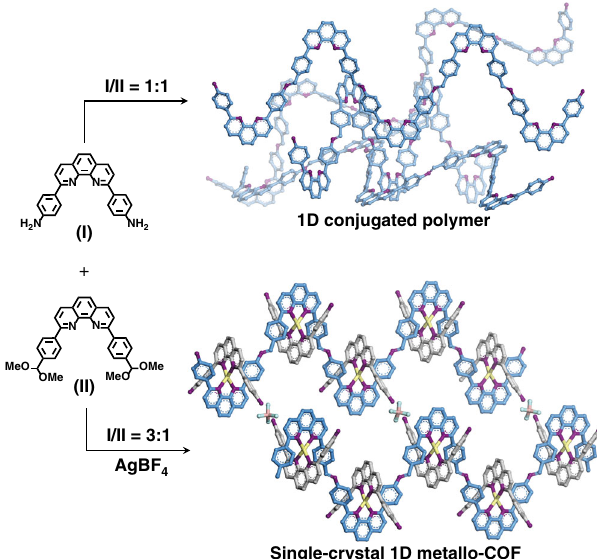
Fig. 1 Strategy of synthesising single-crystalline 1D metallo-COF. Colour scheme: C on organic chains, blue; C on pendants, grey; N, purple; Ag, yellow; B, pink; F, green. Hydrogen atoms are omitted for